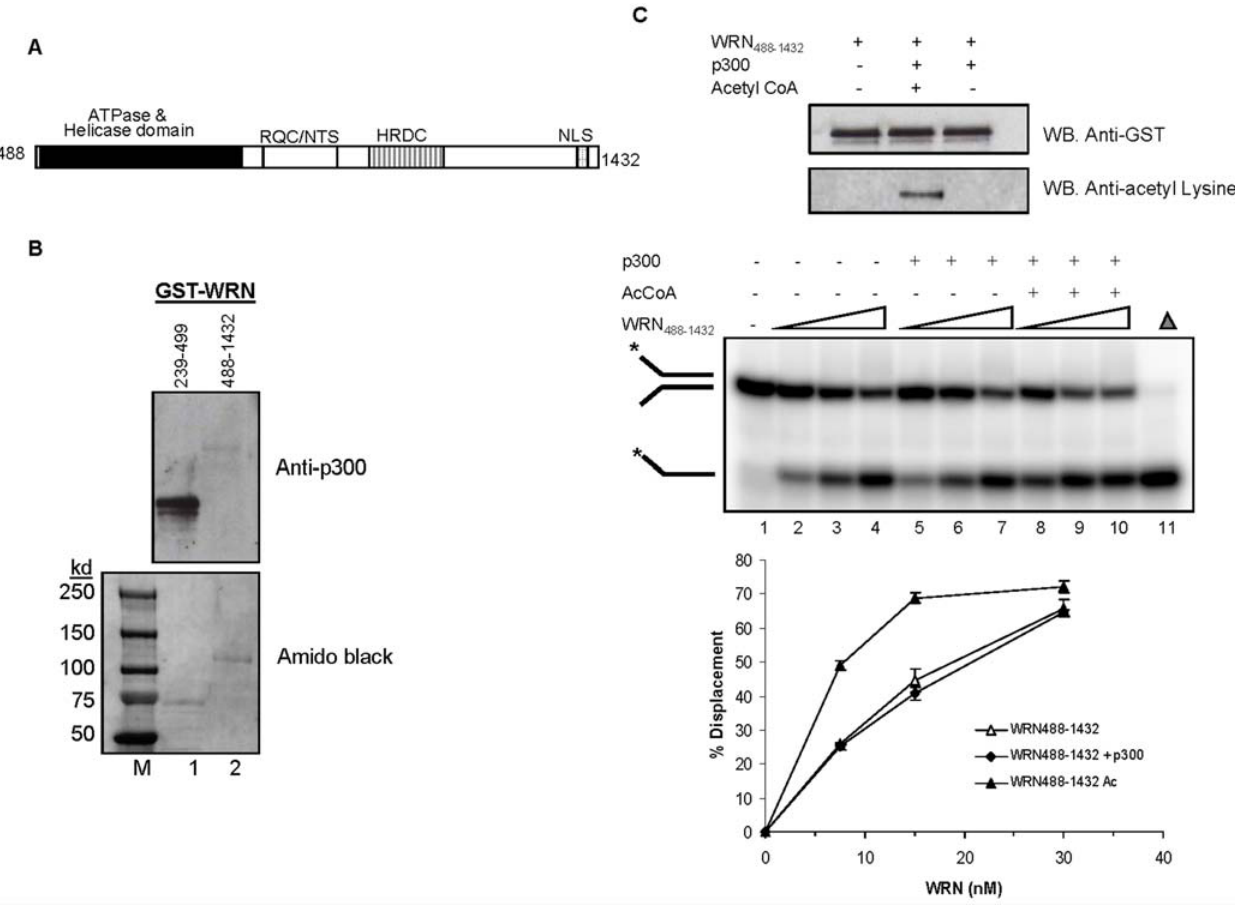
Figure 6. Acetylation of WRN 488–1432 stimulates its helicase activity. (A) A schematic representation of GST- WRN 488–1432 fragment. (B) Recombinant WRN 239–499 and WRN 488–1432 fragments were separated by SDS-PAGE, transferred to a membrane, and stained with amido black to ensure equal loading of the WRN fragments (bottom panel, lanes 1 and 2). The membrane was blotted with p300 protein and probed with mouse anti-p300 antibody (top panel, lanes 1 and 2). (C) One microgram of WRN 488–1432 fragment was incubated with in the presence or absence of acetyl CoA or p300 or both. The top panel shows Western analysis results of WRN 488–1432 fragment after the acetylation assay, which was stripped and analyzed using an anti-acetyl lysine antibody (bottom panel). These reaction mixtures were used in the measurement of helicase activity (medium panel). Medium panel: Reactions containing increasing amounts (7.5, 15, and 30 fmol) of nonacetylated WRN 488–1432 fragment (lanes 2 to 4) and acetylated WRN 488–1432 fragment (lanes 8 to 10) were incubated with a 22 bp forked substrate (0.5 nM, 22Fork3/22Fork4) for 15 min at 37 u C. Lanes 5 to 7,